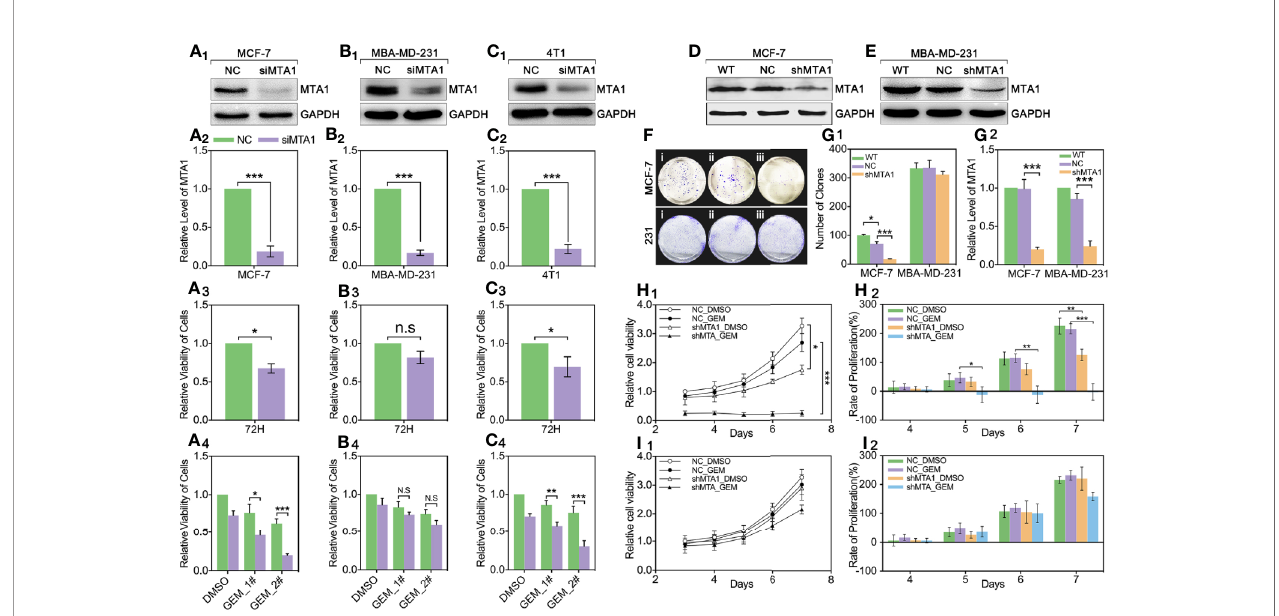
FIGURE 2 | Down regulation of MTA1 sensitized gemcitabine-induced tumor growth regression in MCF-7 cell lines. (1) WB and statistics for small interfere RNA (siRNA) induced MTA1 knockdown in breast cancer cell lines: MCF-6, MBA-MD-231 and 4T1 (A 1-2 – C 1-2 ) . (2) viability of cells, tested by MTT after 48h-treatment of siRNA and 72h culturing in 96-wells plates (A 3 – C 3 ) . (3) cells are treated with siRNA for 48h followed by 48h-treatment of DMSO, 5 m M gemcitabine or 10 m M of gemcitabine (A 4 – C 4 ) . (4) Stable knockdown of MTA1 in MCF-7 and MBA-MD-231 cells, veri fi ed by WB (D, E, G 2 ) . (5) Cloning formation of WT_ MCF-7/MBA-MD- 231(i), NC_ MCF-7/MBA-MD-231(ii) and shMTA1_MCF-7/MBA-MD-231(iii) cells (F, G 1 ) . (6) NC_ MCF-7 and shMTA1_MCF-7 are treated with gemcitabine or DMSO for 48h, and then are cultured in fresh complete medium for 5 days, in which cells are tested for viability through MTT every day, and cell growth was inhibited as compared with NC